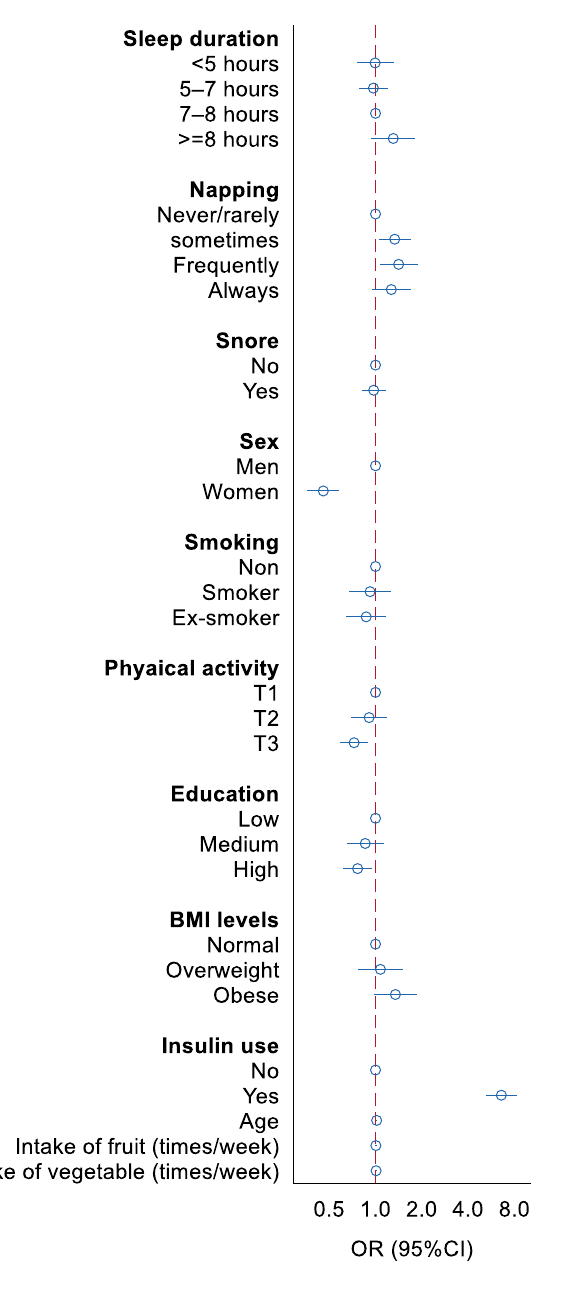
Figure 1. Association between sleep and other lifestyles with poor glycemic control. All the varia- bles were mutually adjusted in the